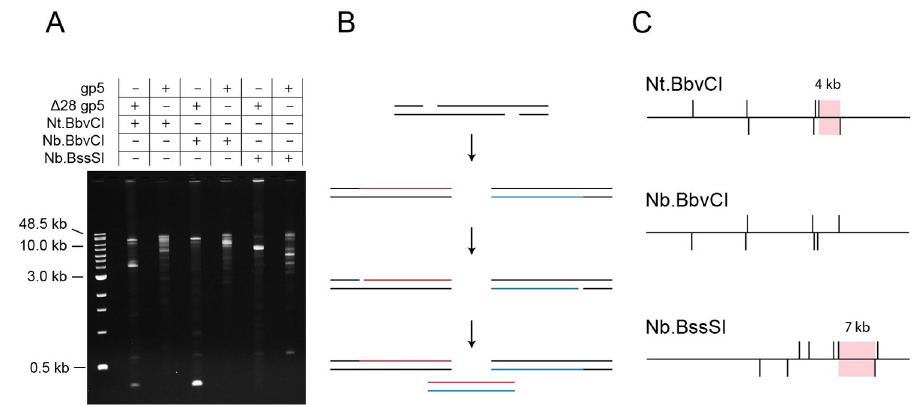
Fig 1. Agarose gel electrophoresis of T7 SDA reactions. (A) Amplicons produced in the reaction of λ DNA with a NEase and either the WT or Δ 28 gp5 T7 replisome. (B) A scheme for DNA amplification of a region between two NEase recognition sites. (C) Illustration of NEase recognition sites within the linear λ phage genome. Vertical lines above the horizontal correspond to nicks on the top strand of DNA, and those below to nicks on the bottom strand of DNA. Shaded regions correspond to amplicons.